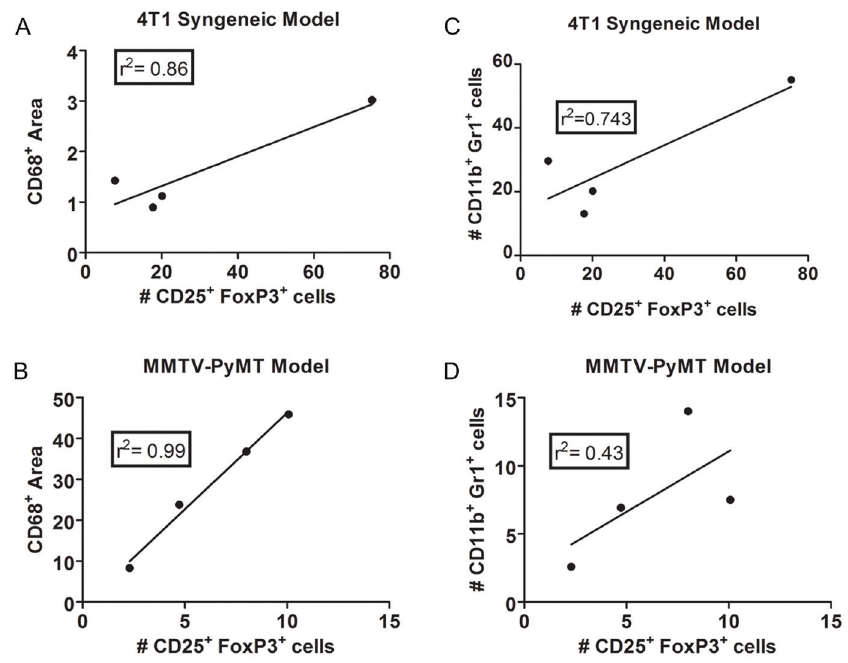
Figure 1. Macrophage infiltration correlates with the accumulation of CD25 + FoxP3 + regulatory T-cells in two pre-clinical models of breast cancer following anti-VEGF therapy. Mice in each experiment received therapy with either control antibody (C44), mouse-chimeric r84 (inhibits the VEGF: VEGFR2 interaction), sunitinib (inhibits VEGFR1, VEGFR2 PDGFRβ, c -kit), or GU81 (inhibits VEGFR1 and VEGFR2). (A, B) By linear regression analysis, changes intra-tumoral T number following anti-VEGF reg therapy positively correlate with CD68 + macrophage levels after four weeks of therapy in the 4T1 syngeneic (A) and MMTV-PyMT transgenic breast cancer models (B). Each dot represents the mean for CD68 + area and the number of T in each treatment group. (C, D) regs By linear regression analysis, changes in intra-tumor T number positively correlate with reg the number of CD11b+ Gr1+ MDSCs following four weeks of therapy in the 4T1 syngenic (C) but not the MMTV-PyMT transgenic (D) breast cancer model. Each dot represents the in each treatment mean for the number of MDSCs and T regs